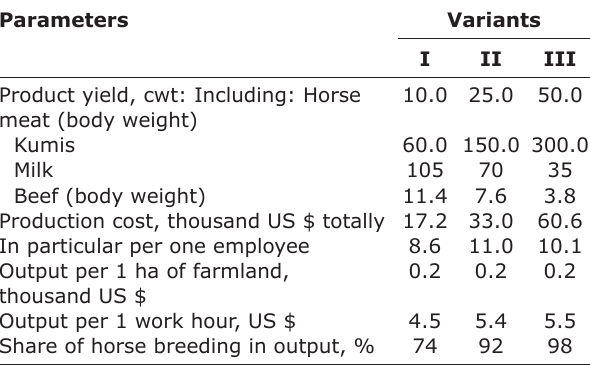
Table-4: Economic results of horse peasant farms. Parameters